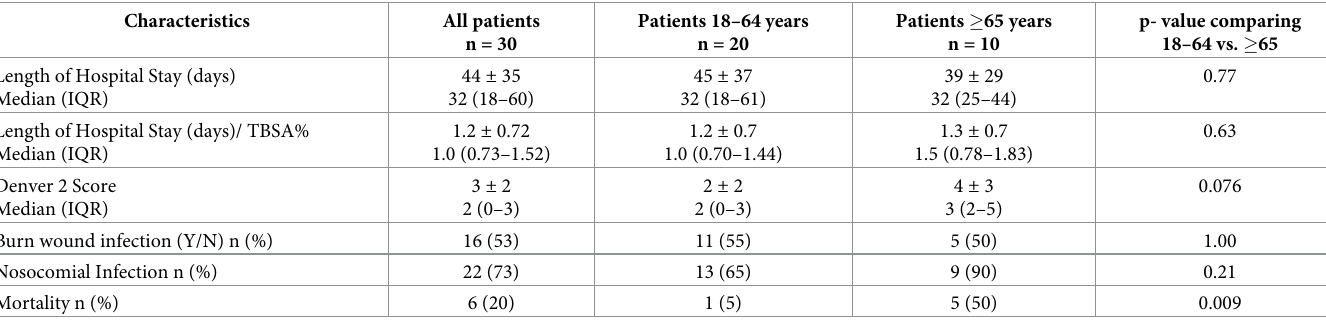
differences, 888 genes were significantly upregulated in the elderly group and 1451 were down- regulated. Enrichment maps revealed multiple immune-related pathways were found to be downregulated in elderly patients compared to adults (Fig 1). Elderly patients in this subgroup showed altered expression of genes related to antigen processing, specifically via MHC class I, ubiquitination and proteasome degradation. Many pathways involved in cell signalling, such as NF- κ B, C-type lectin receptor, and T cell receptor signalling were significantly downregu- lated. Pathways relating to antiviral immunity were also suppressed in the elderly. Group 2 (High TBSA). Of the 7488 gene sets examined, 5114 were upregulated in the elderly group, and 2374 were downregulated compared to adult controls (p < 1). When a p value of 0.0001 was utilized to detect statistically significant differences, 621 genes were signifi- cantly upregulated in the elderly group, while 512 were significantly downregulated. As TBSA increased, more upregulated pathways in elderly patients were detected, however, the global picture was that the transcripteomic profile in elderly burn patients is profoundly Table 2. Patient outcomes.